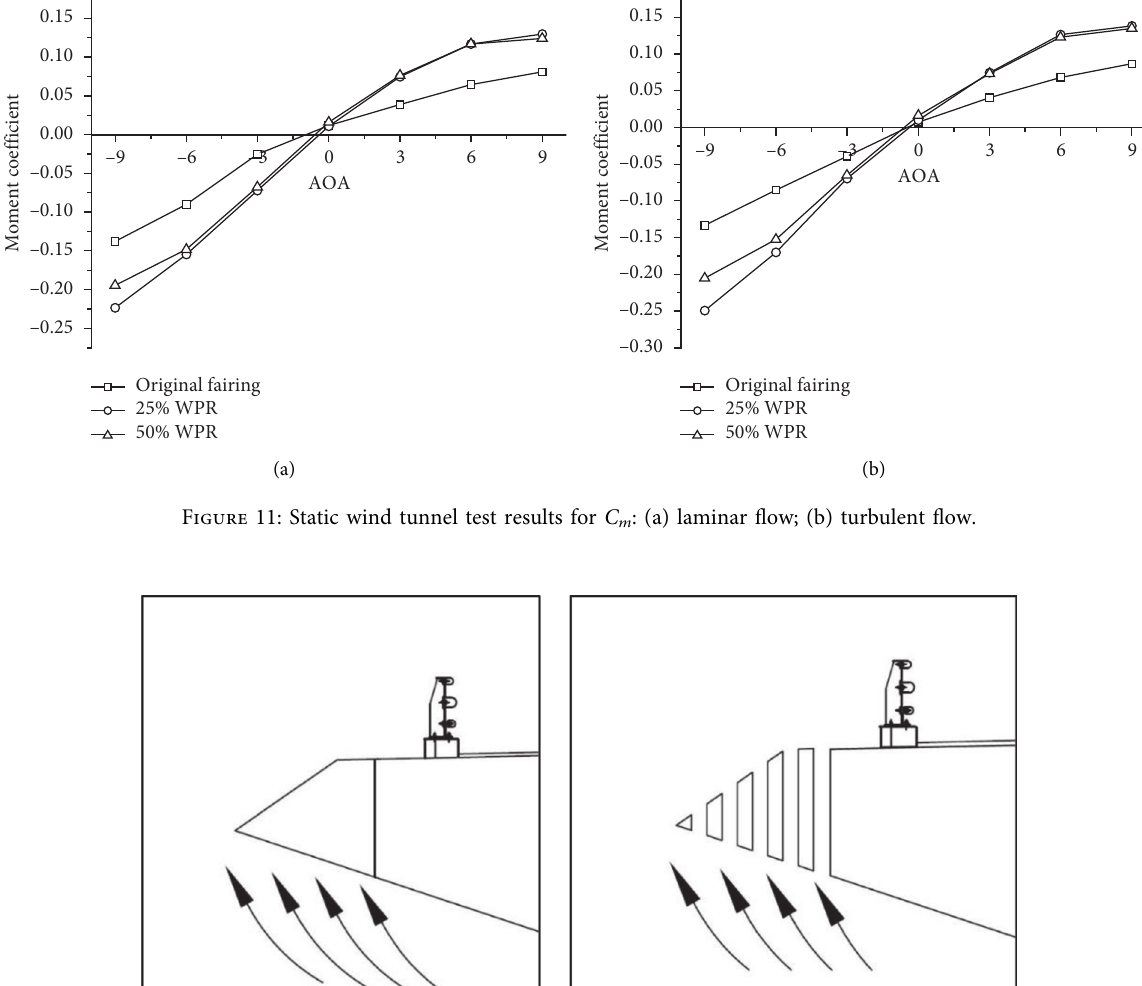
Figure 12: Schematic of the increase of wind resisting area for torsional moment by applying the proposed